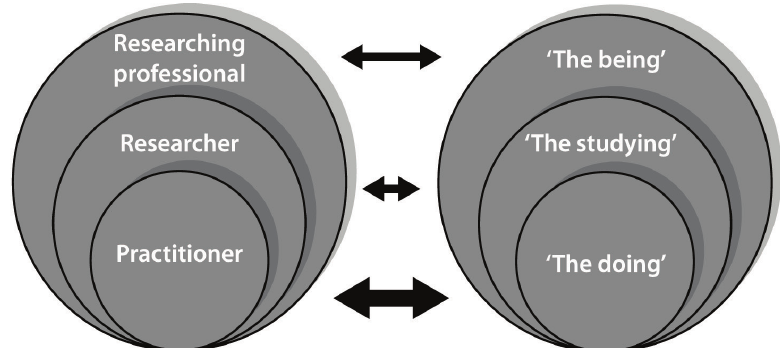
Figure 2: Overarching identity of the researching